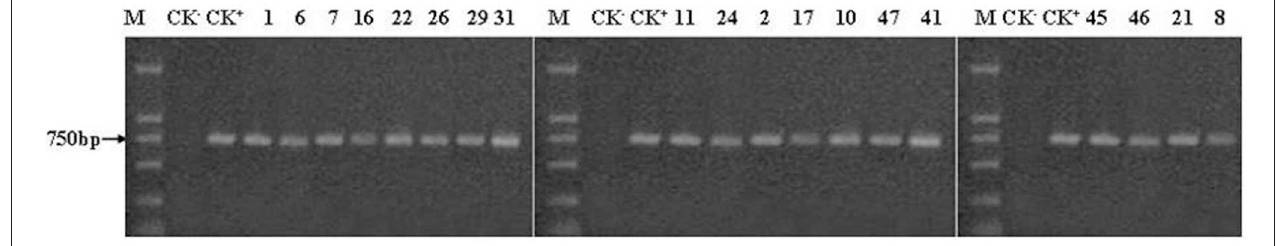
FIGURE 2 | PCR amplification of the Cry1Ac gene. M, DL marker 2,000; CK − , negative control (non-transgenic poplar); CK + , positive control (plasmid pBtiA); the others are the 6-year-old transgenic lines. 19 transgenic lines and the positive control were all detected the expected bands (749 bp), while the negative control was not detected.